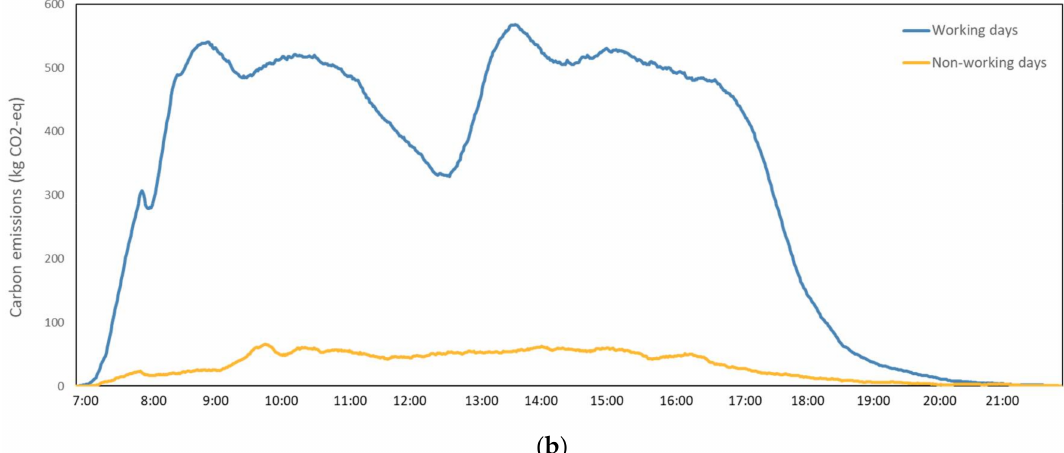
Figure 9. Time of day profiles of freight tips and carbon emission in Hong Kong: ( a ) Number of trips; ( b ) Carbon emission. Note: “end time” was described as the “time_in” in the Dataset 1; “start time” was calculated as “end_time” minus “trip